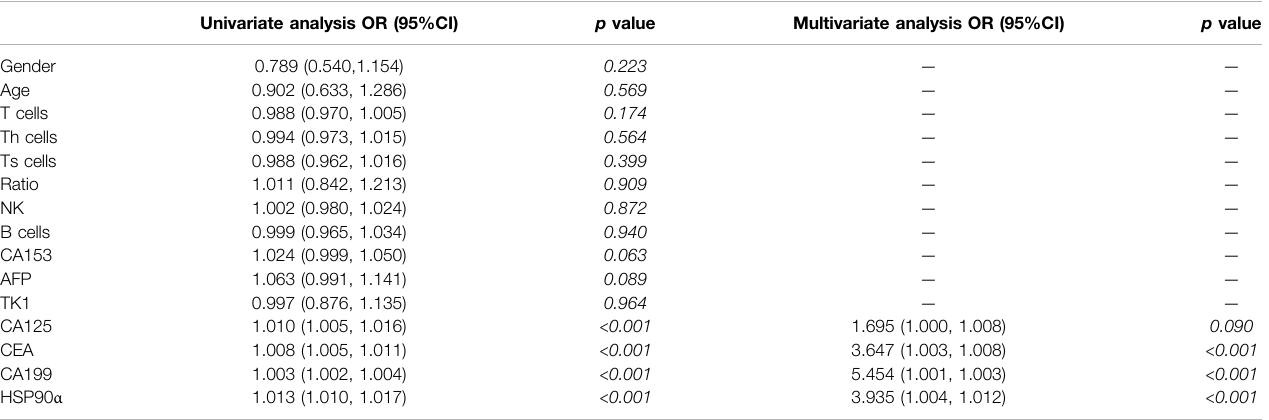
TABLE 3 | Univariate and multivariate analysis for factors associated with metastasis in colorectal